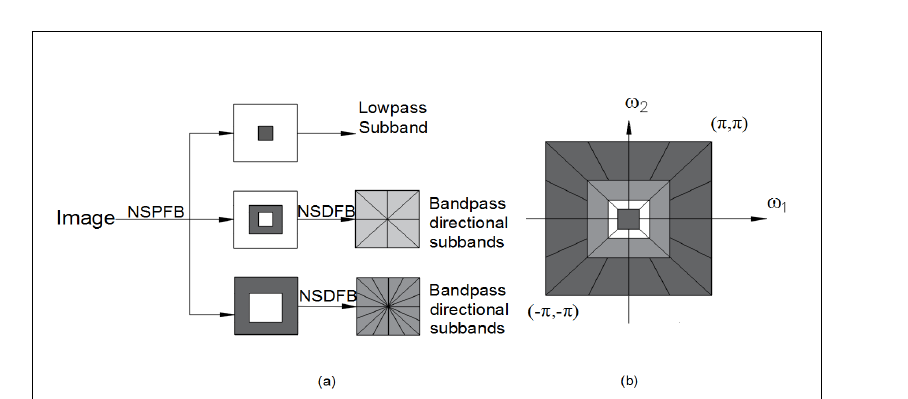
Figure 2. Nonsubsampled Contourlet Transform (NSCT)